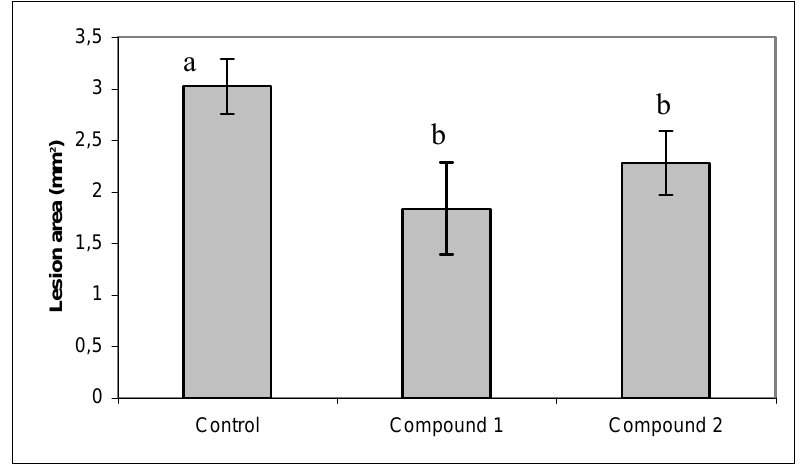
Figure 4 . Effect of compounds 1 and 2 on ability of B. cinerea to colonize tomato leaves. The methanol solution (control) or compounds 1 or 2 at 60 μ g mL -1 were spread on the surface of the leaves with a paintbrush. Five μ L of a conidia suspension (10 5 conidia mL -1 ) was inoculated on the upper side of the tomato leaves and leaves were incubated at 22 °C. After four days of incubation, the lesion area on tomato leaves was measured. Each bar represents the mean of at least three independent experiments ± standard deviation. Different letters indicate that the means are significantly different at P <